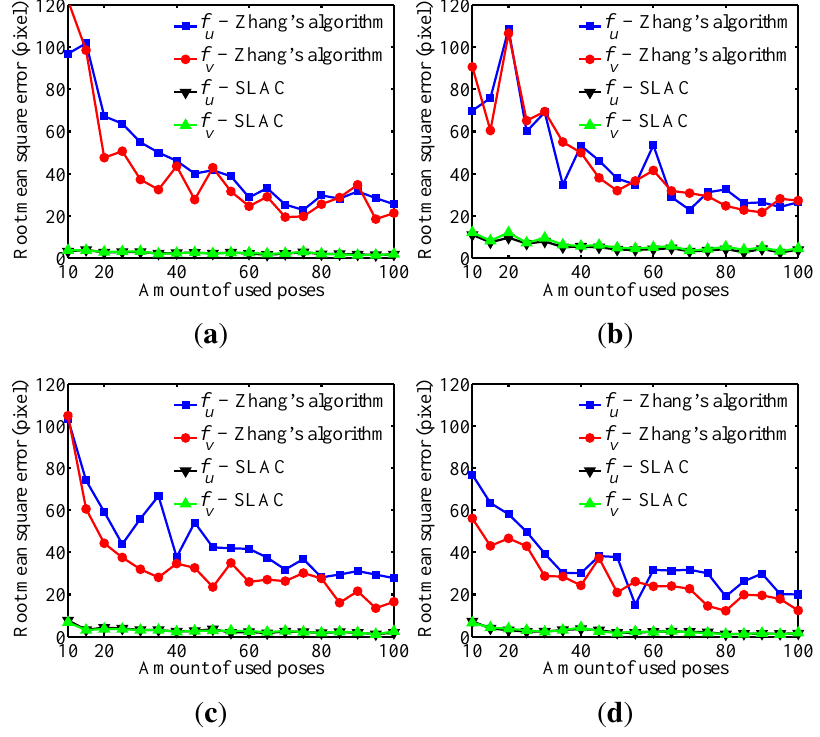
and v parameters for different amounts of used 0 0